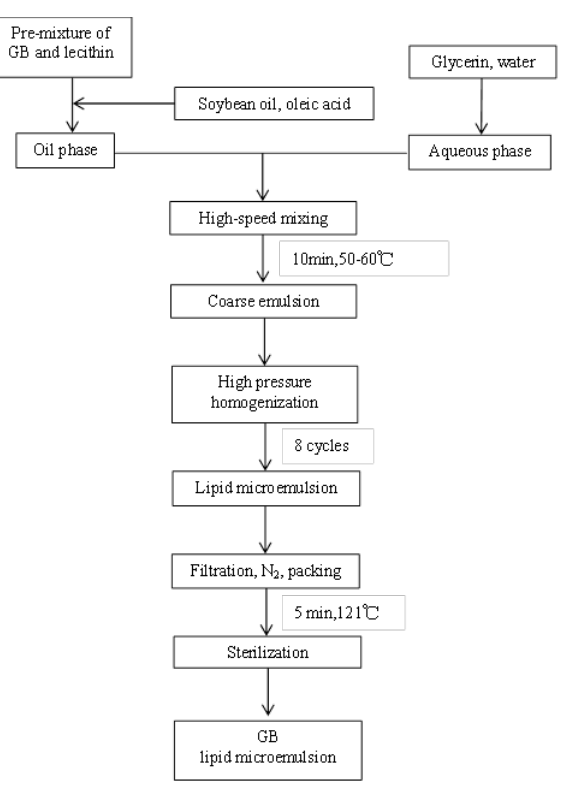
Figure 1: Manufacturing process of GB lipid microemulsion.